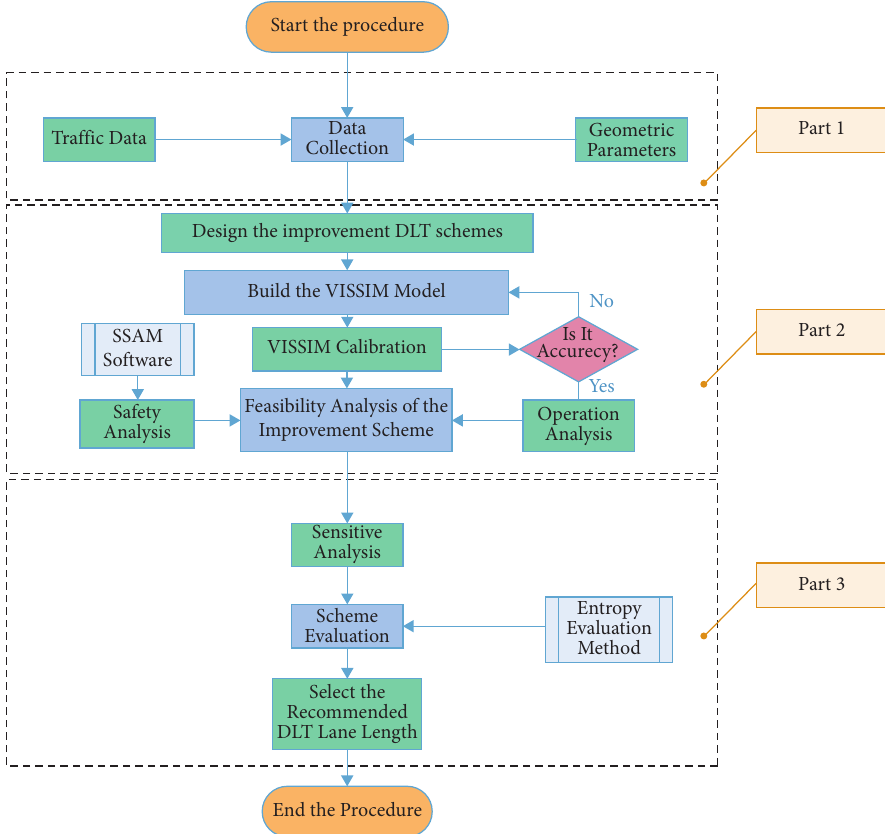
Figure 1: The flowchart of the evaluation and analysis model based on entropy evaluation method for the design